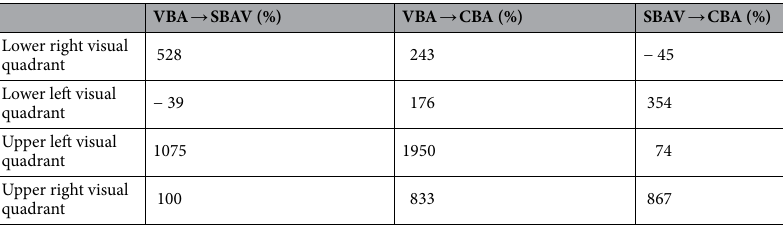
VBA → SBAV (%) VBA → CBA (%) SBAV → CBA (%)